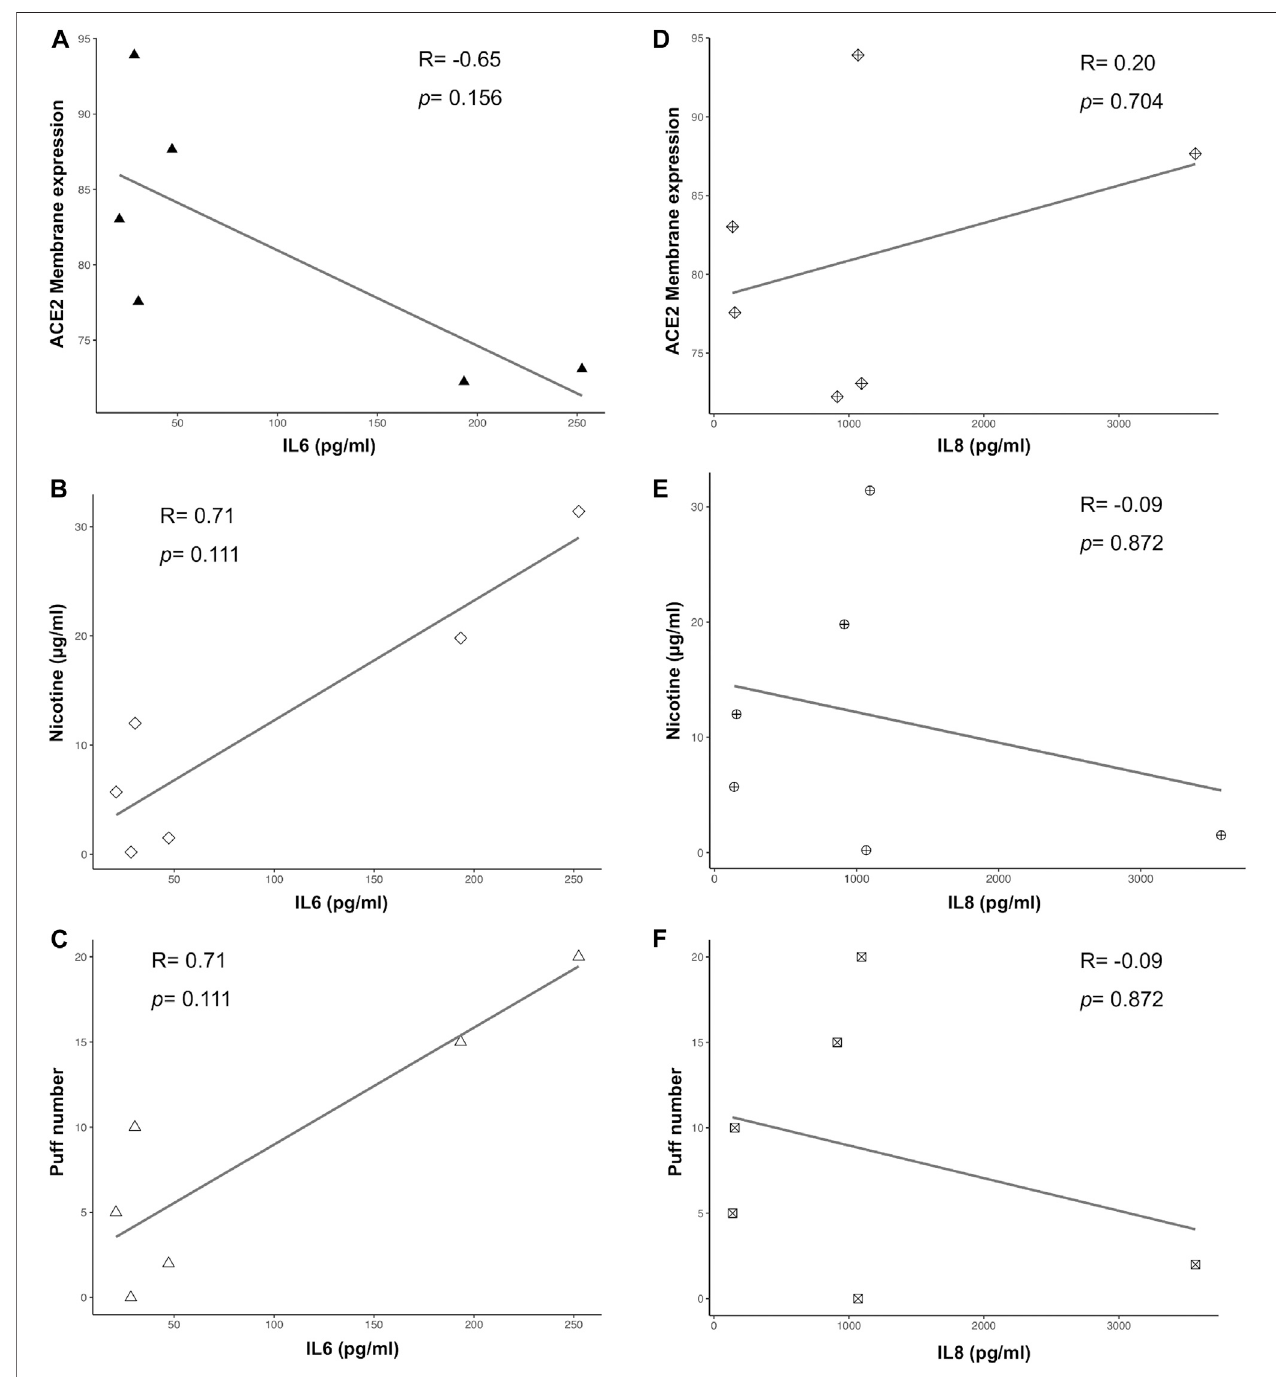
FIGURE 6 | Scatter plots of correlation analyses of both IL6 (A-C) and IL8 (D-F) vs ACE2 membrane expression, puff number and nicotine dosage. Correlations were determined using Spearman correlation.